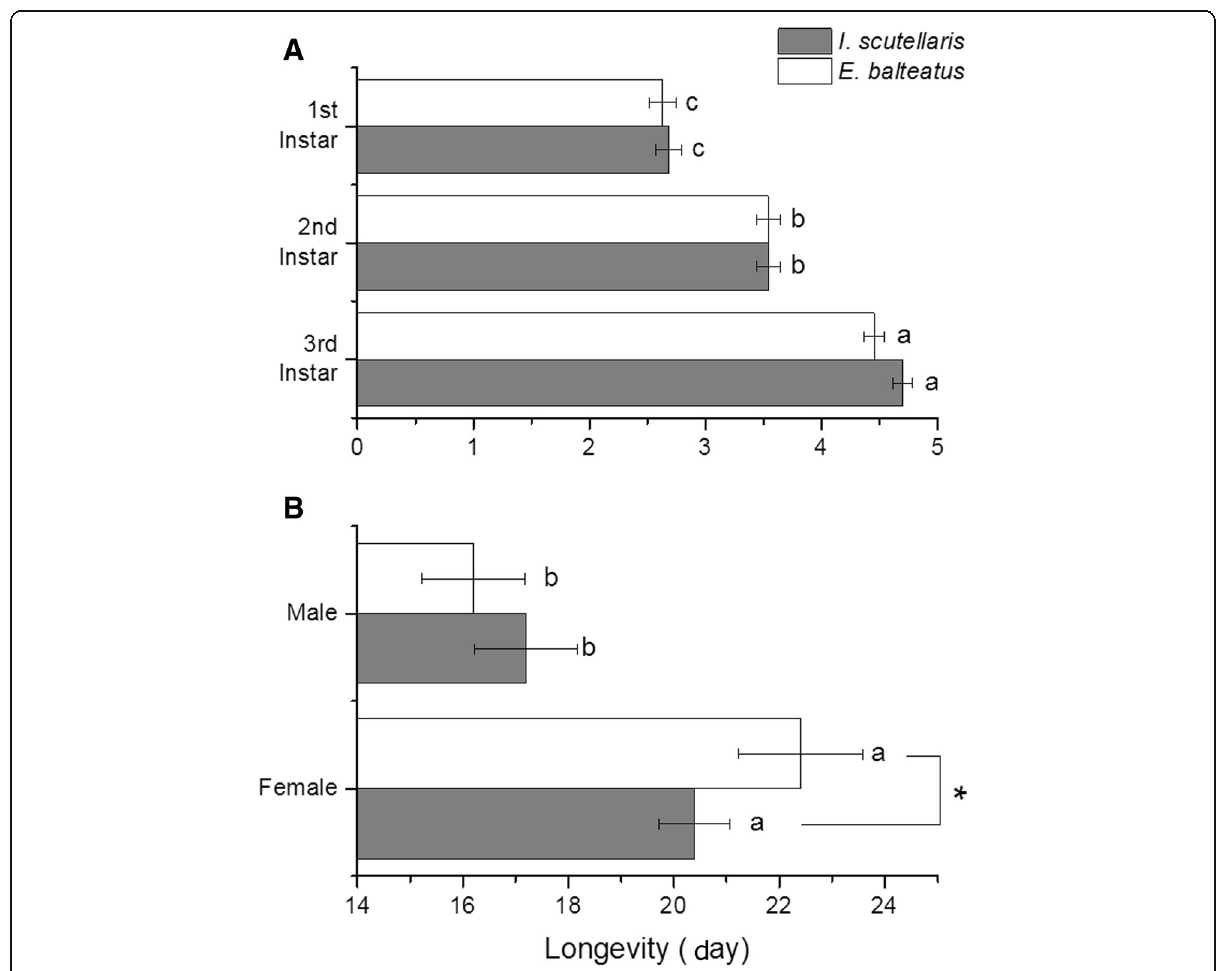
Fig. 2 Comparative fitness of larval instars ( a ) and adult flies ( b ) of I. scutellaris and E. balteatus , expressed in terms of developmental times of each stage. The bars are means± SEM, and the different lowercase letters above each bar demonstrate significant differences within the data, while an asterisk above a pair of the bars presents a significant difference between two predator species ( P <